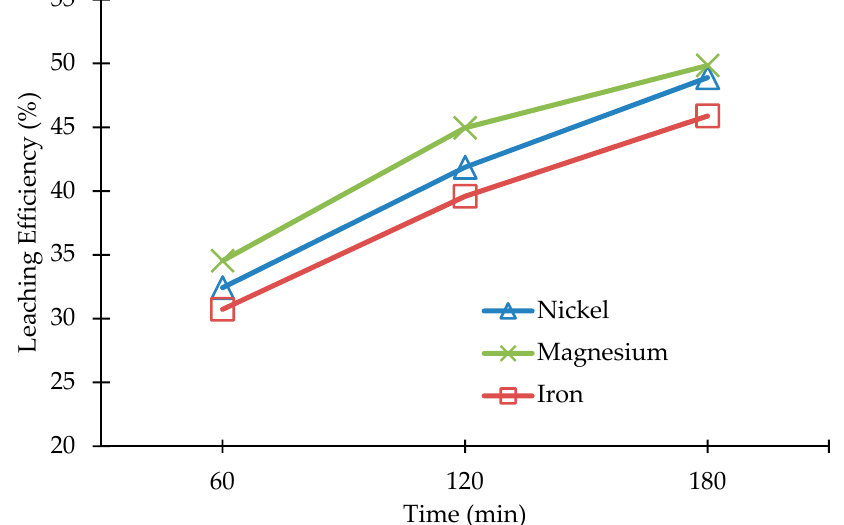
Figure 10. Leaching efficiency of carbonated olivine depending on leaching time, 20–63 µm, 50 °C, 1 M HCl and 300 rpm.